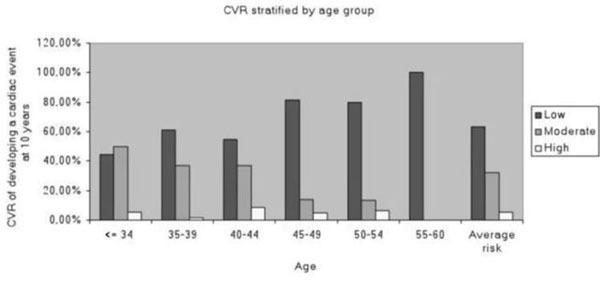
CVR stratified by age group.